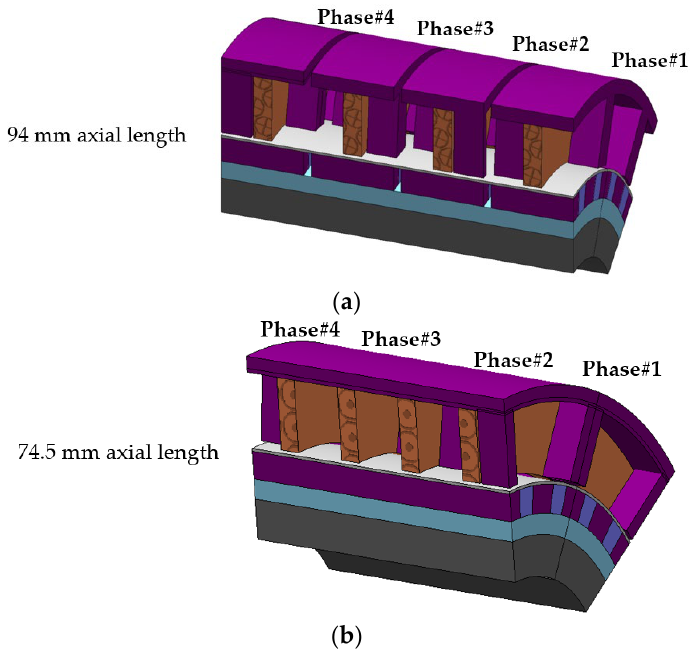
Figure 4. Extension of optimum one phase TFM to 4–single phase TFM, ( a ) axially separated rotor and stator; ( b ) combined phase rotor and stator.